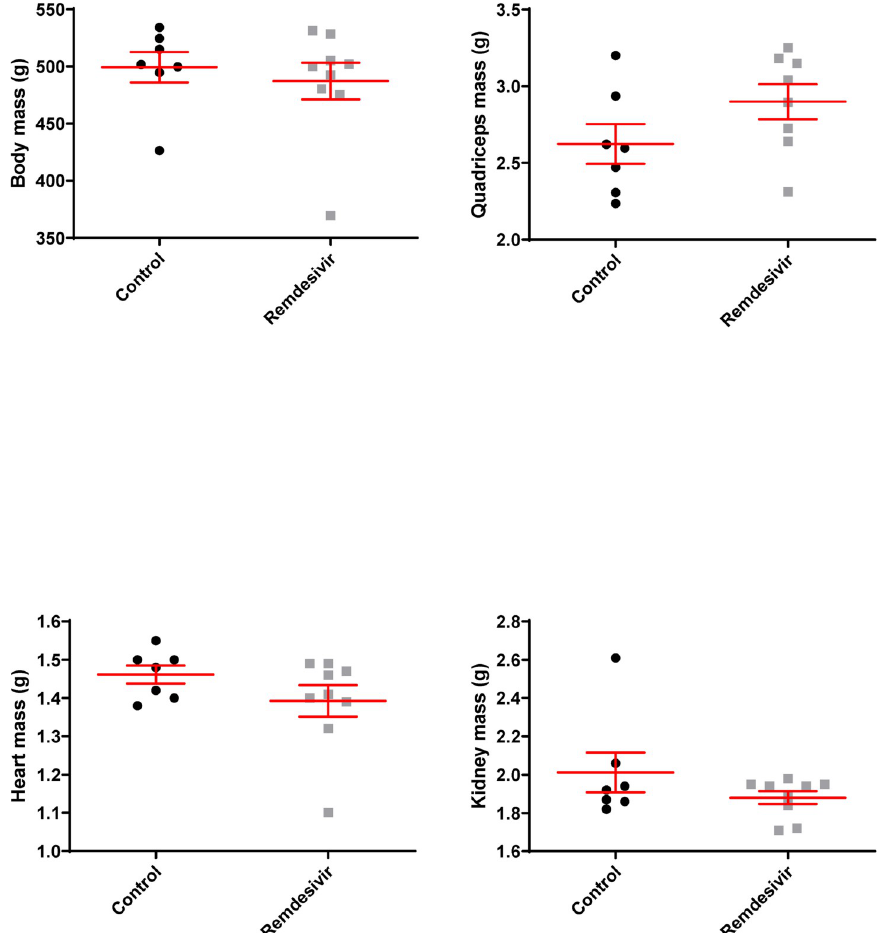
Fig 2. Effects of three months of remdesivir treatment on body, heart, kidney and quadriceps mass in hybrid rats. Rats were weighed at 33 months of age before they were sacrificed. Whisker plots denote mean and SEM. Black circles denote control rats, grey squares denote remdesivir-treated rats. N = 7–9 per experimental group.